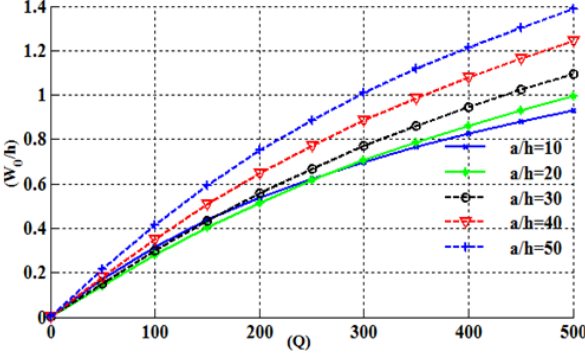
UDL and CC boundary condition. The effect of longitudi- nal stress is higher as compared to transverse